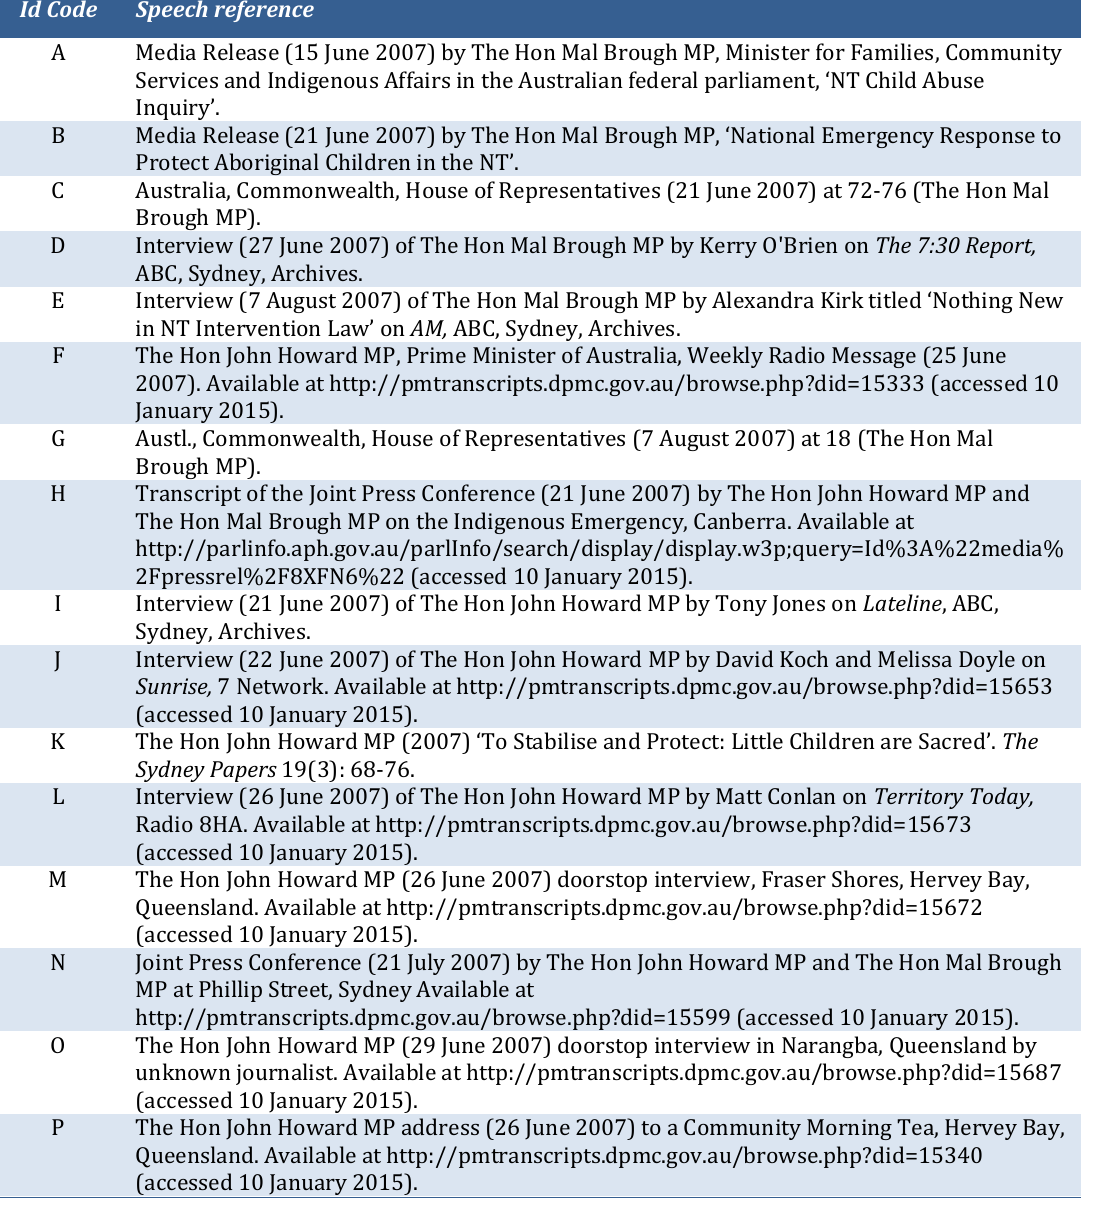
Table 1: Summary of speech acts identified by actor(s) Id Code Speech